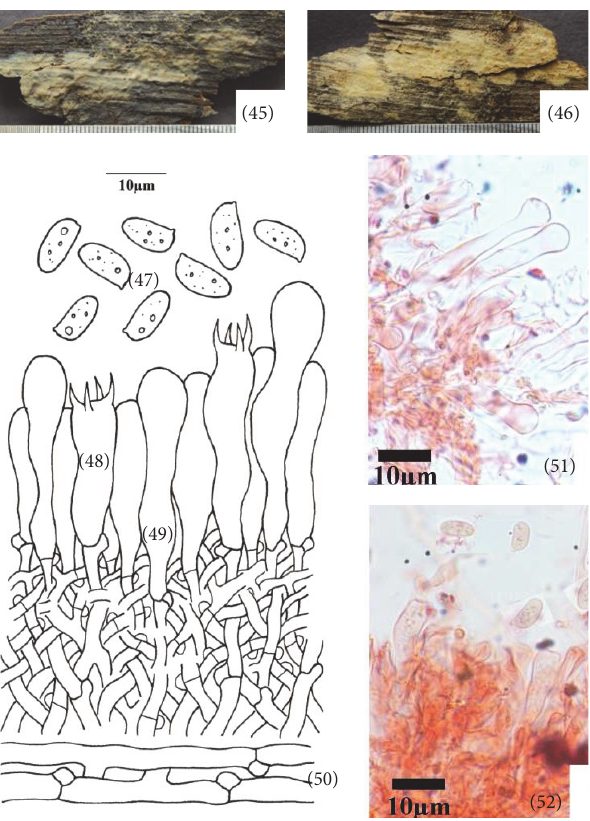
Figure 7: Hyphoderma tibia (45)–(52). (45) Fresh basidiocarp, (46) dried basidiocarp, (47) basidiospores, (48) basidium, (49) cystidium, (50) generative hyphae, (51) photomicrographs showing cystidium, and (52) photomicrographs showing